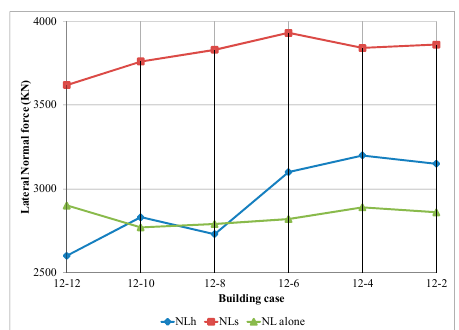
Figure 18. Lateral normal force at the foundation of the single and the two adjacent buildings with unequal foundation levels and SSI.